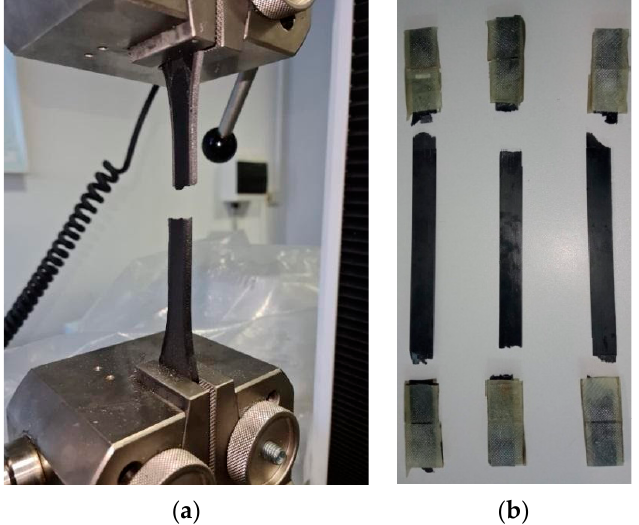
Figure 13. Samples at the end of the tensile test: ( a ) ONYX sample; ( b ) ONYX_R samples.